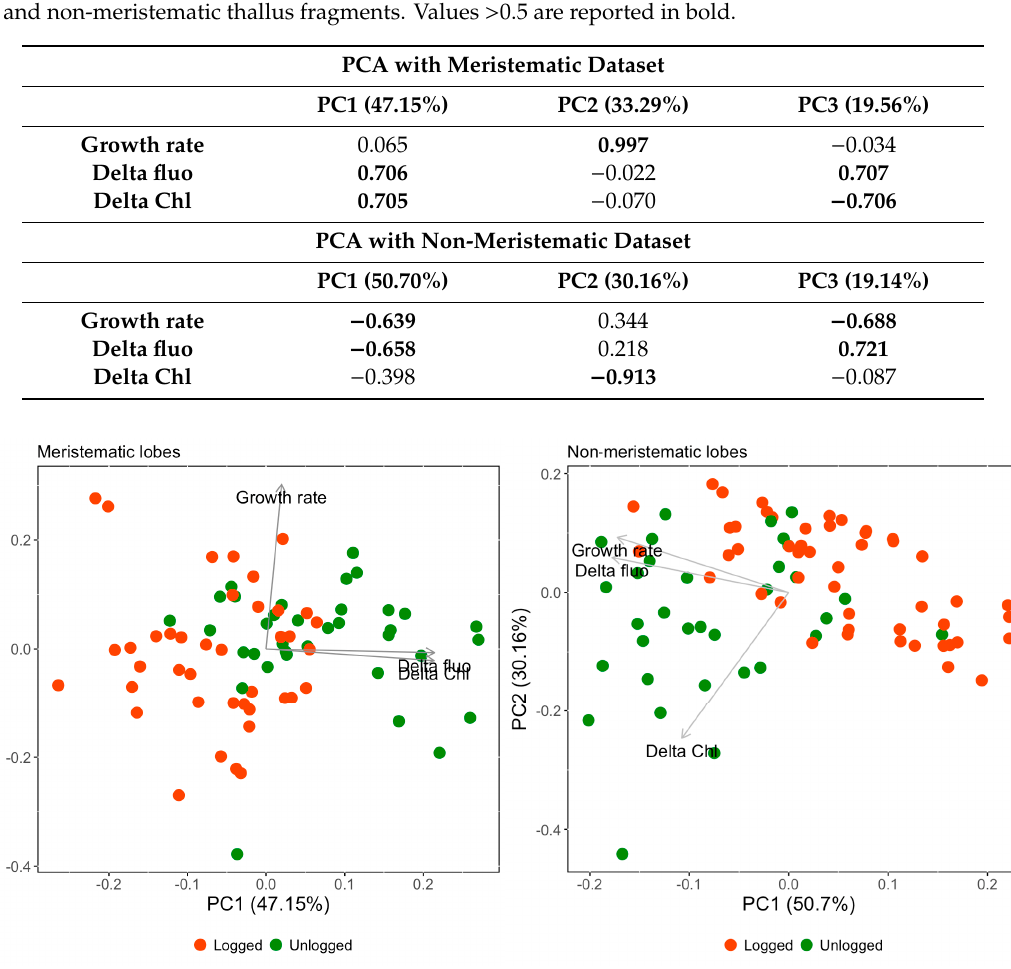
Figure 4. Score plots of the Principal Component Analysis obtained for meristematic (ordination on the left) and non-meristematic fragments (on the right). Distribution of meristematic lobes in logged and unlogged stand: 40 and 35 samples, respectively; non-meristematic fragments: 49 and 33 samples,